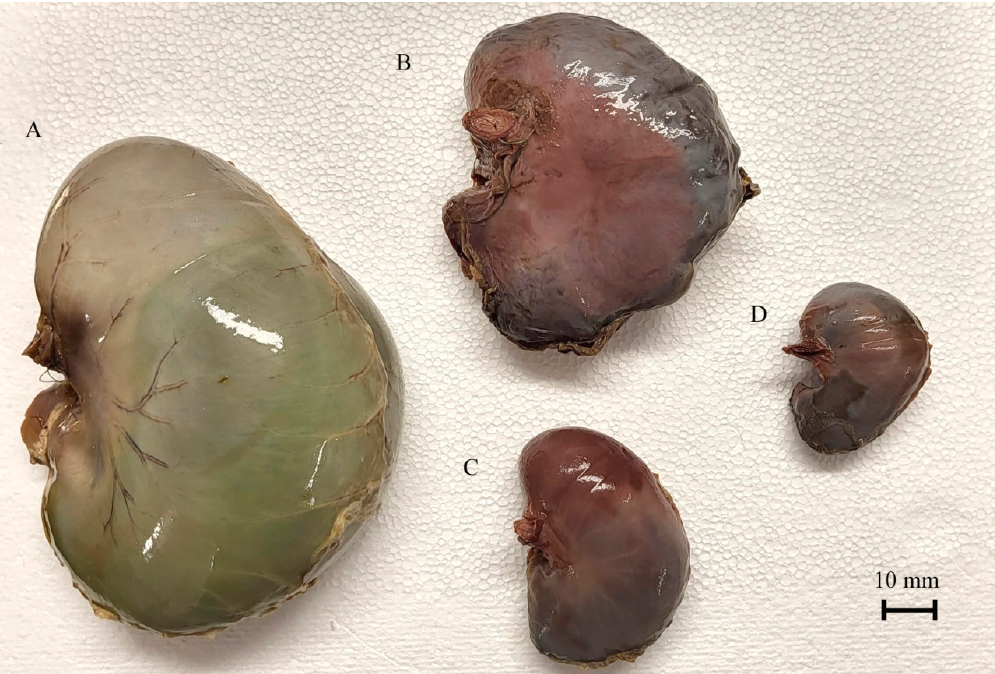
Figure 6. Equine fetal stomach (the visceral surface view). A—the third age group, B—the second age group, C and D—the first age group.